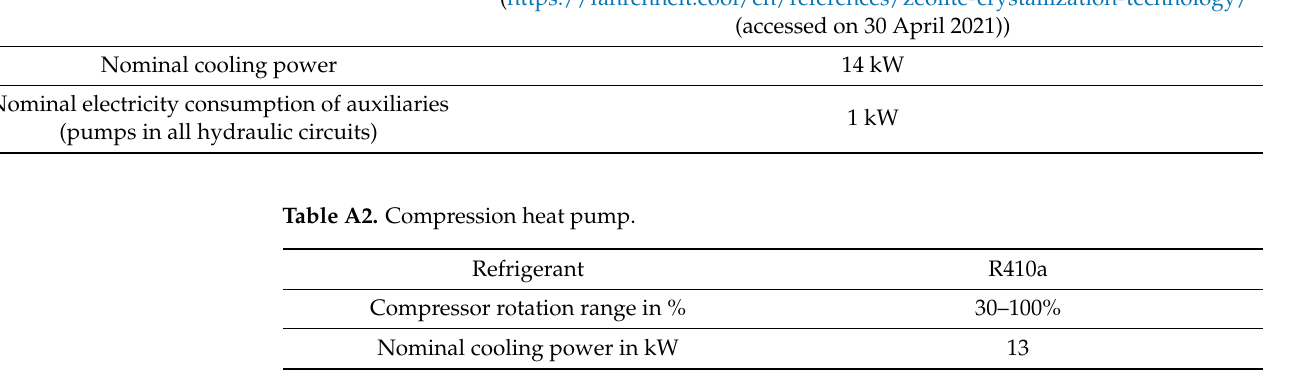
Table A3. Three-fluid heat exchanger for latent